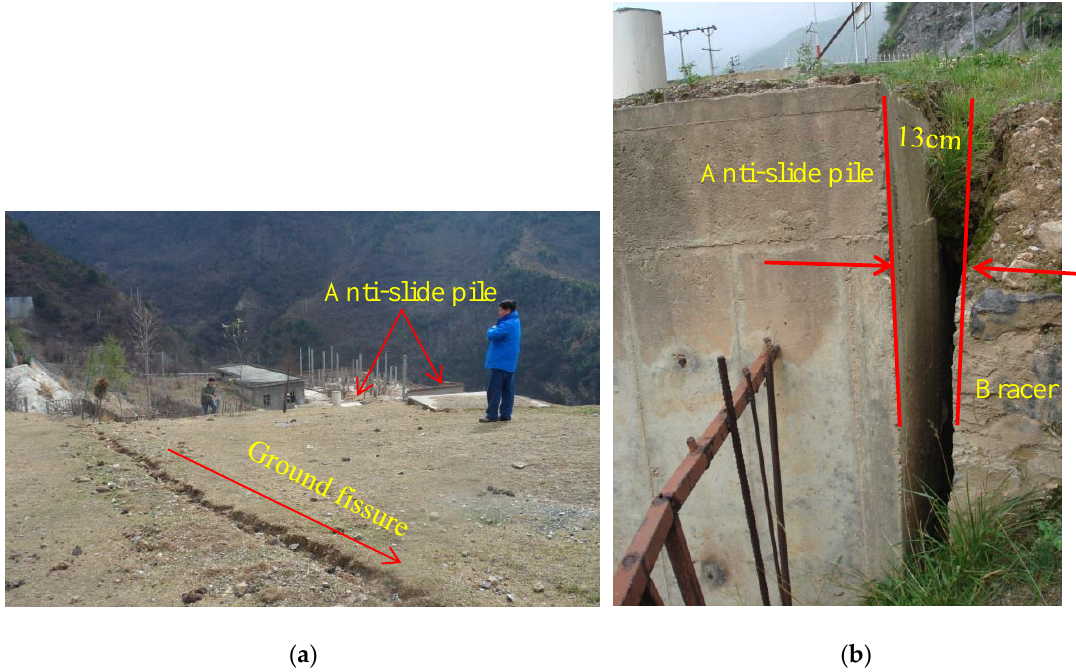
Figure 3. Investigation. ( a ) Ground cracking behind anti-slide piles. ( b ) Displacement of the anti-slide pile head in site investigation.